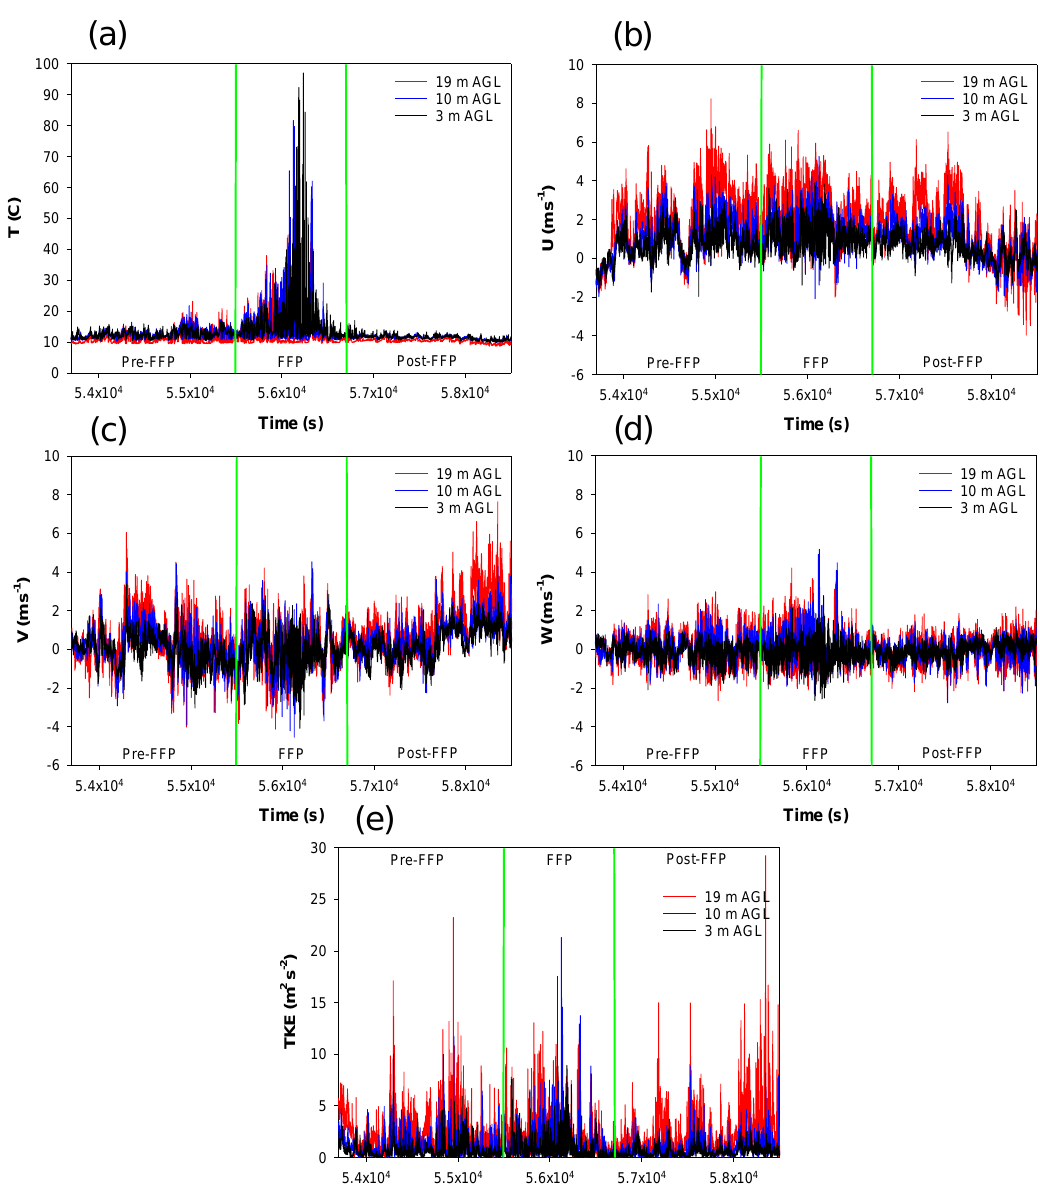
Figure 4. Time series of ( a ) temperature ( 𝑇 ), ( b ) tilt-corrected zonal wind velocity ( 𝑈 ), ( c ) tilt-corrected meridional wind velocity ( 𝑉 ), ( d ) tilt-corrected vertical wind velocity ( 𝑊 ), and ( e ) turbulent kinetic energy ( 𝑇𝐾𝐸 ) at 3 m, 10 m, and 19 m AGL before, during, and after fire-front-passage at the west tower.